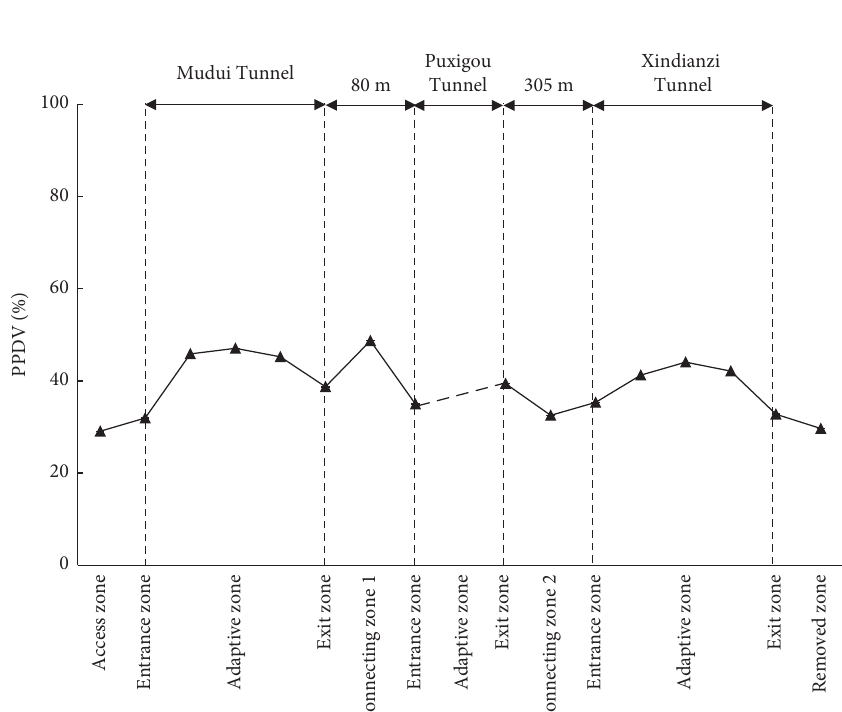
Figure 12: Zone analysis of Mudui-Xindianzi Tunnel